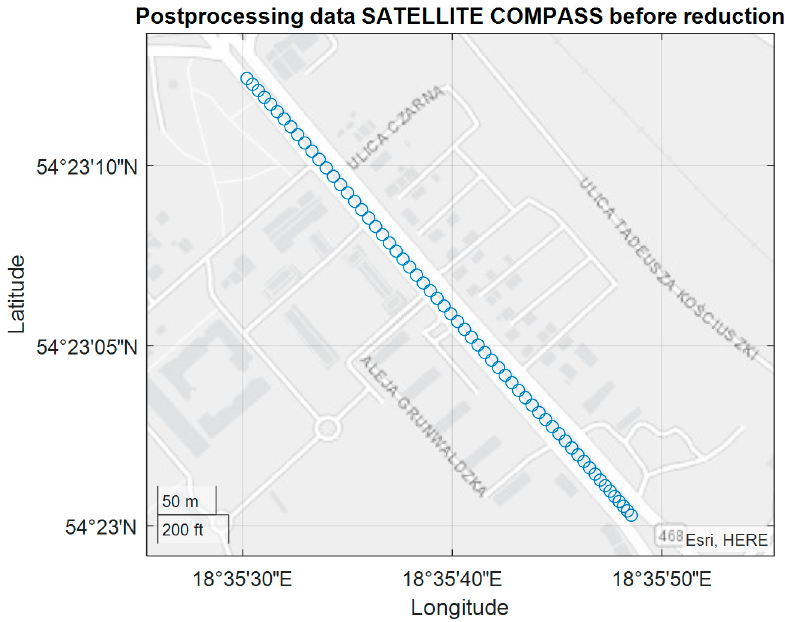
Figure 17. Position registration of the tram from 23:06:25 (UTC) - Universal Time Coordinated to 23:07:25 UTC.